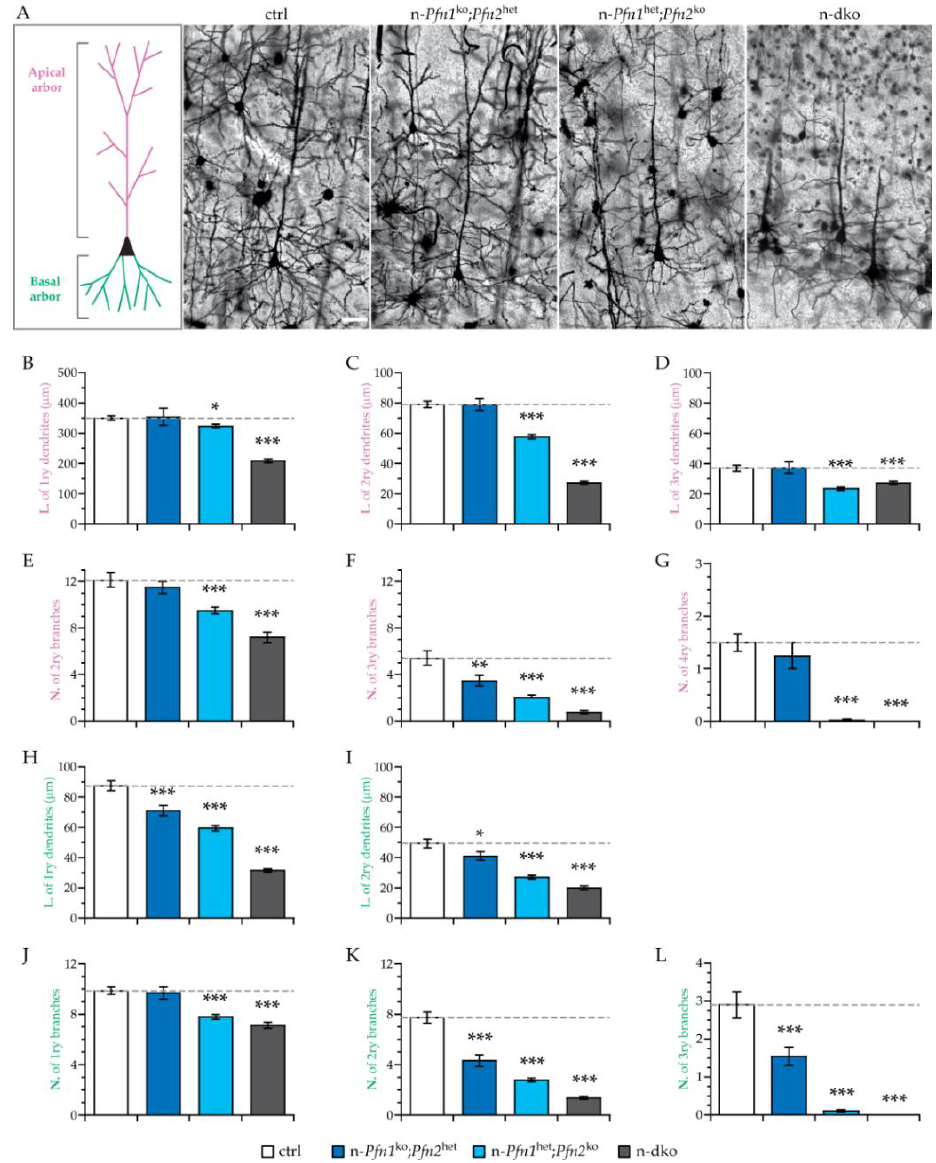
Figure 7. Length and complexity of dendritic arborizations in layer V cortical neurons are reduced proportionally to the profilin expressed. ( A ) Sample images of Golgi-stained layer V cortical neurons in control (ctrl), n- Pfn1 ko ; Pfn2 het , n- Pfn1 het ; Pfn2 ko , and n-dko P80–90 mouse brain slices. The drawing on the left side is a schematic representation of a wt layer V cortical neuron in scale with the neurons in the images. Length (L) of apical ( B ) primary dendrites, as well as of ( C ) secondary and ( D ) tertiary branches of layer V cortical neurons, is reduced compared to controls proportionally to the reduction in expressed profilin; one Pfn2 allele is sufficient to rescue dendrite length but not one Pfn1 allele. The number (N) of ( E ) secondary, ( F ) tertiary, and ( G ) quaternary apical branches is strongly reduced in profilin double mutant neurons compared to controls proportionally to the reduction in profilin levels. No quaternary branches were found in n-dko and single Pfn1 allele cortical neurons. Length (L) of basal ( H ) primary and ( I ) secondary dendrites is reduced in profilin mutant neurons compared to controls, similarly to the apical dendrites. The number (N) of basal ( J ) primary, ( K ) secondary, and ( L ) tertiary branches is strongly reduced in n-dko neurons compared to controls, similarly to the apical dendrites. No tertiary branches were found in n-dko and single Pfn1 allele cortical neurons. For each parameter, one-way ANOVA with Dunnett’s post-hoc test was applied to compare to ctrl values; n = 35/2 (neurons/mice) per genotype. Error bars represent the SEM; * p ≤ 0.05, ** p ≤ 0.01, *** p ≤ 0.001. Scale bar: 40 µ